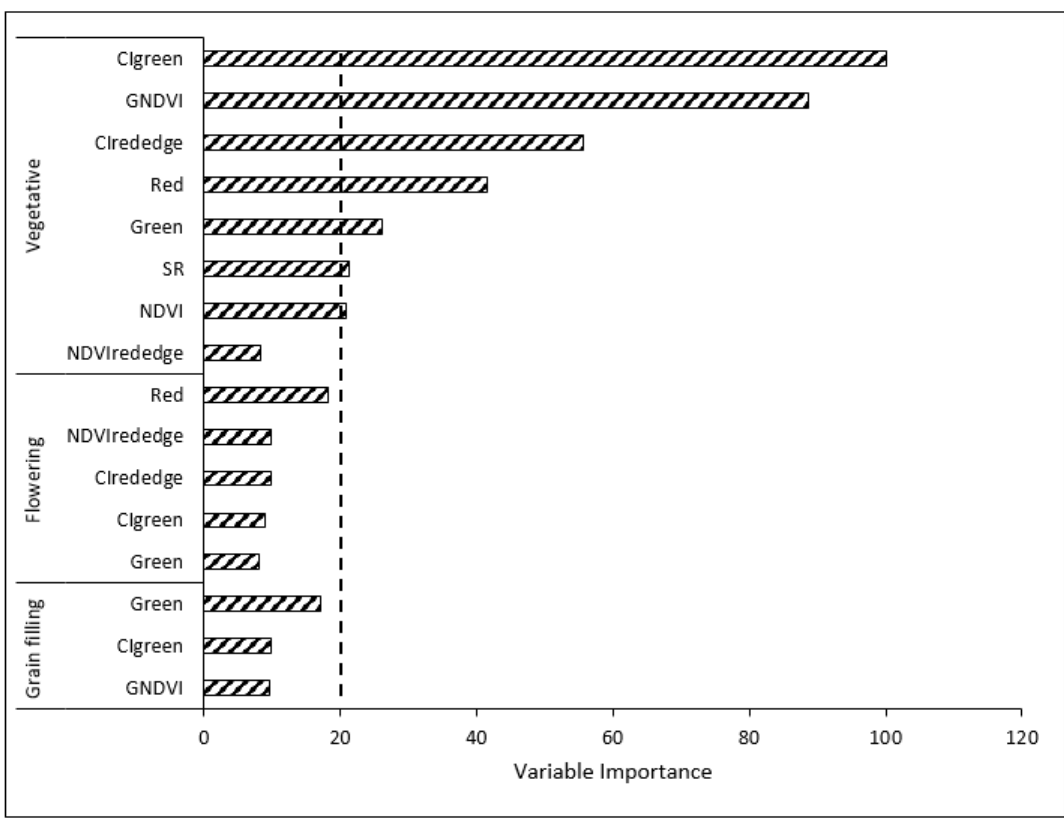
Figure 9. Optimization of variables for varietal classification using RF-OOB for different spectral bands and vegetation indices. The vertical dotted line indicates the cut-off point for selected variables. NDVI = Normalized Difference Vegetation Index; GNDVI = Green Normalized Difference Vegetation Index; NDVIrededge = Rededge Normalized Difference Vegetation Index; SR = Simple Ratio, CIgreen = Green Chlorophyll Index; CIrededge = Rededge Chlorophyll Index.